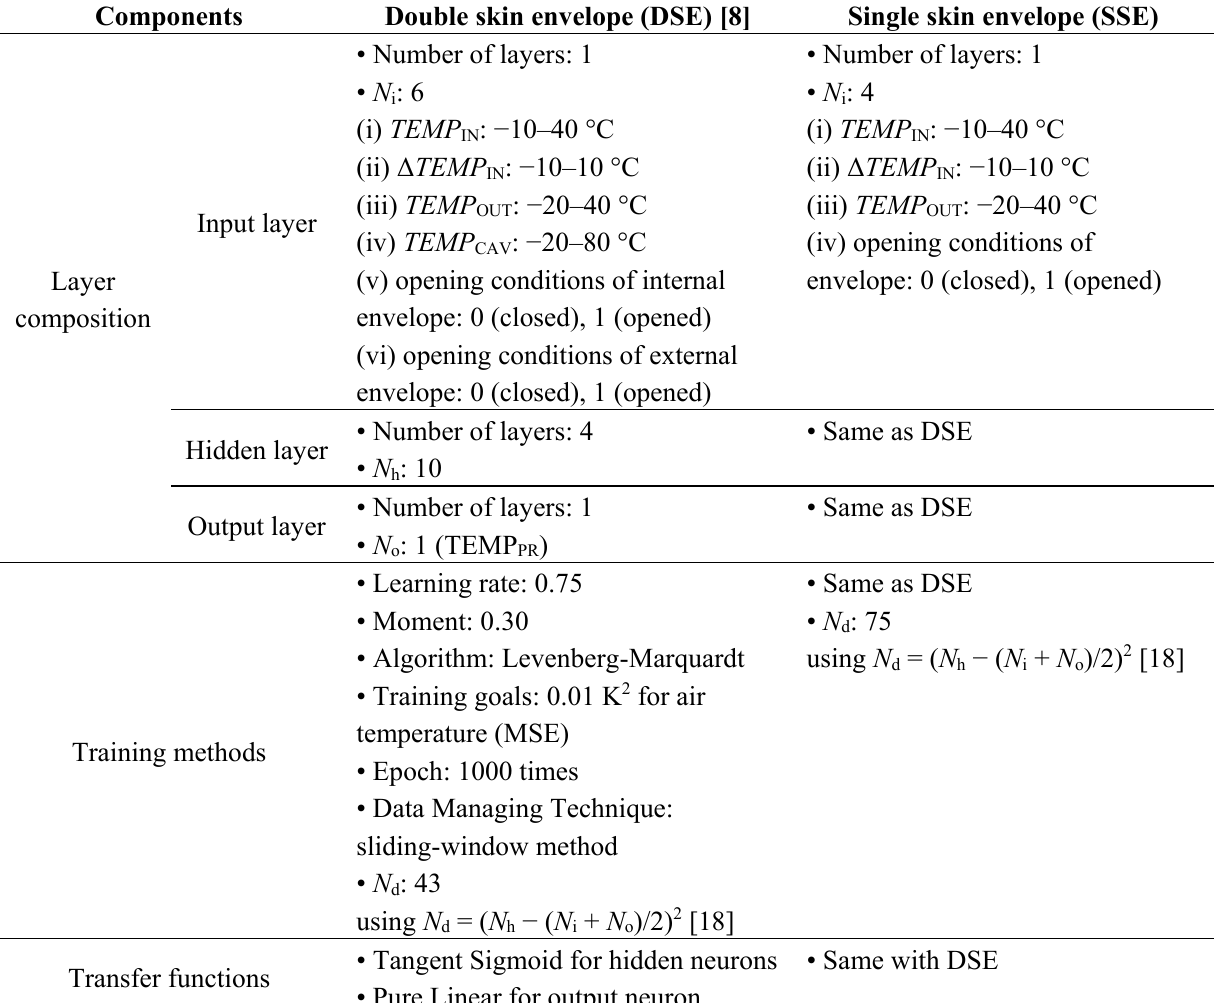
Table 1. Composition of the developed ANN